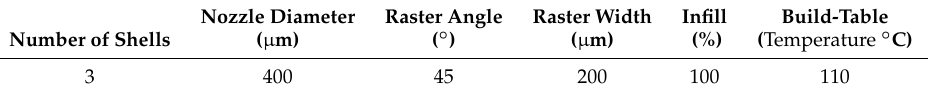
Table 3. 3D print parameters kept constant throughout the design of experiments.